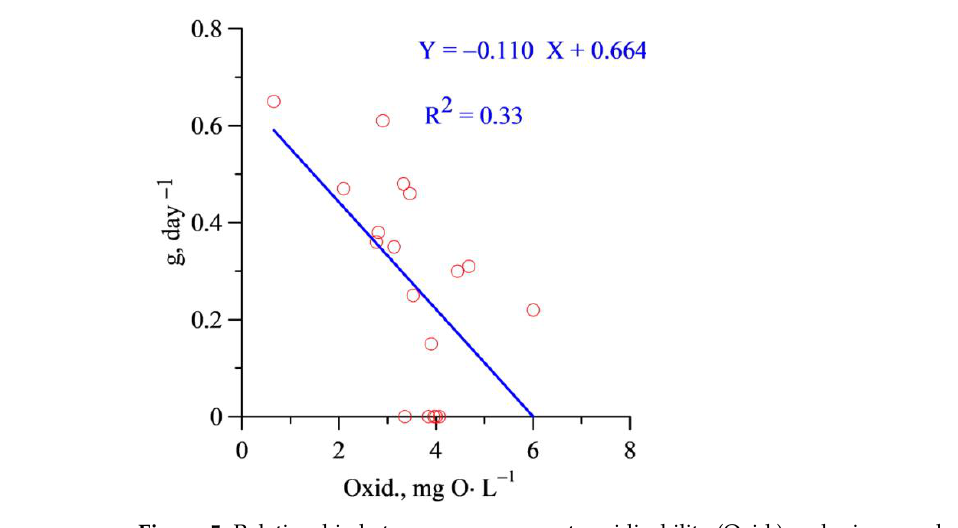
Figure 5. Relationship between permanganate oxidizability (Oxid.) and microzooplankton grazing (g) in the warm period.